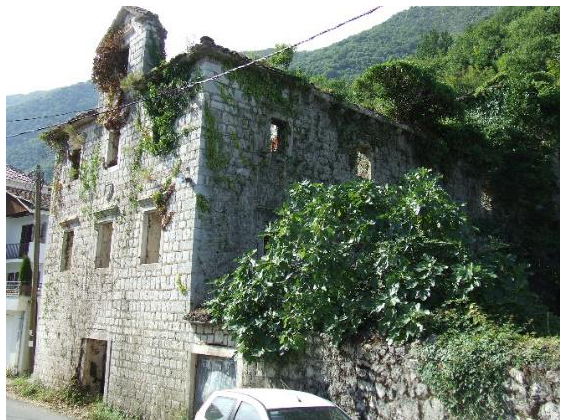
Figure 9. Cracking of belvedere structure in Prčanj and Stoliv.